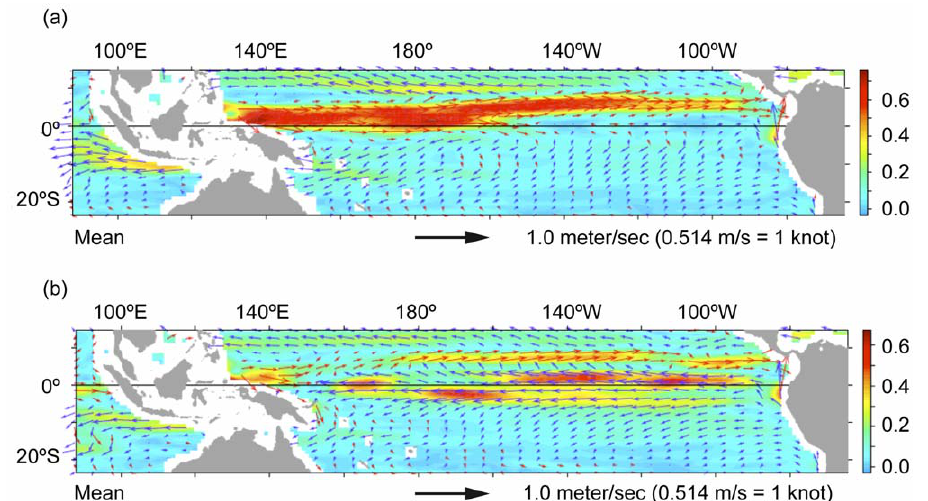
North Equatorial Counter-current (NEECC) as a major feature of the current pattern. (b) Averages for July–December 2000 (common, non-El Nin˜o conditions) showing the presence of the NECC as weaker and reduced compared to the westward flowing Equatorial current. Red overlay vector arrows indicate eastward flows; blue arrows indicate westward flows. Colored contour plots indicate current speed (meters per second) according to scale on the right. Map and information downloaded from http://www.oscar.noaa.gov/datadisplay/.